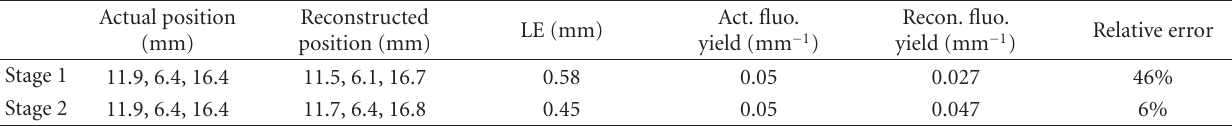
Figure 2: Reconstruction model in the simulation experiment. (a) The torso of the mouse atlas model with a cylindrical fluorophore in the liver; (b) the plane of excitation sources at z = 16 . 4mm. The black points represent the locations of the isotropic point sources. (c) For each point excitation source, there are 39 detectors recording the transmitted light at the opposite side with a 120 ◦ field of view (FOV). Table 2: Quantitative results by our